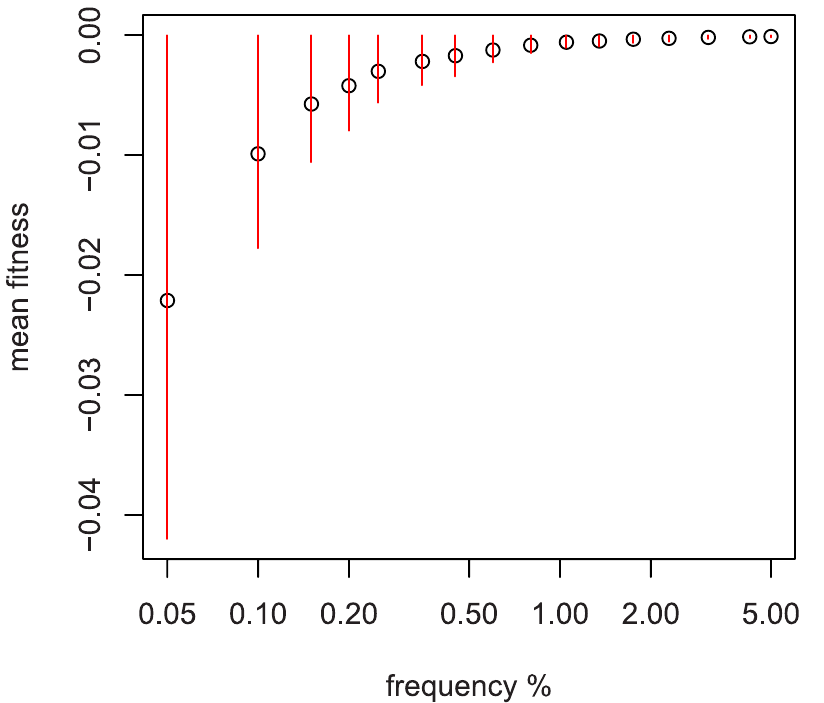
Figure 2. Relationship between sampled frequency and mean fitness. Simulation results using fitted DFE of non-synonymous variation from [33] and a sample size of 1000 diploids. Red bars are median + 2 35% of the distribution at that sampled frequency. The x-axis is logarithmic and scaled by 100, i.e., the first point is 1/2000 chromosomes.